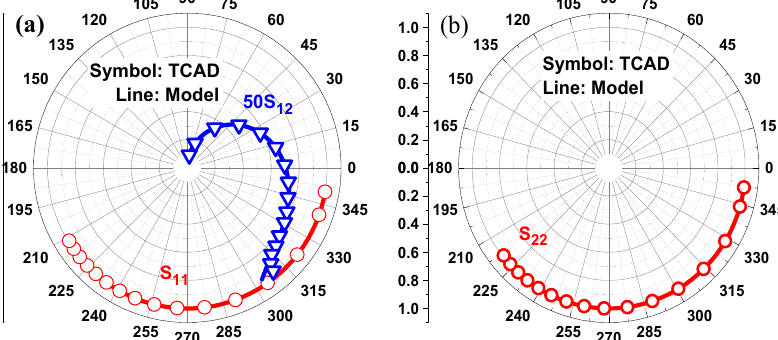
Figure 5. Comparison between simulated and modeled S-parameters for the extrinsic layout OPEN structure. ( a ) S 11 , S 12 and ( b ) S 22 .